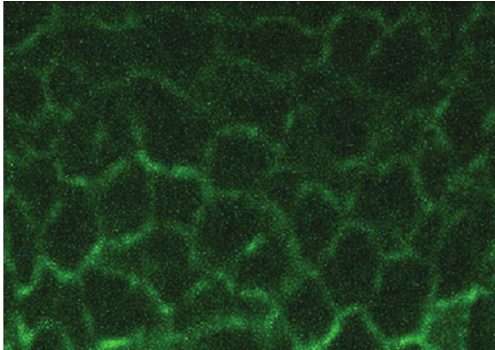
Figure 5: Direct immunofluorescence for deposits of IgG. Deposi- tion of IgG was found between the epithelial